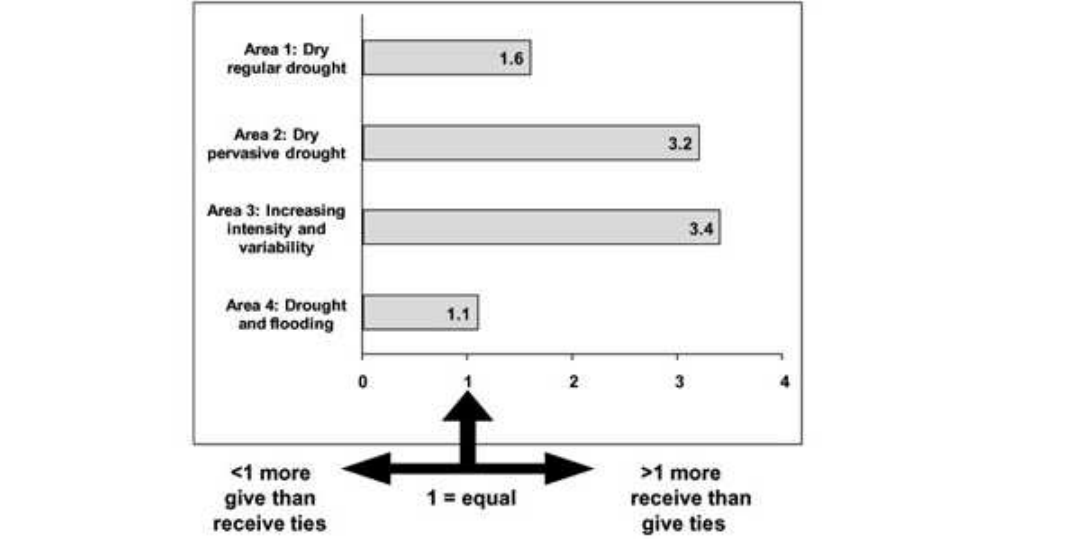
Fig. 3. Direction of reciprocity for each location. Note: Reciprocity results were generated from recorded data of all local and external exchanges for 121 households during 2003-4. These are total number of exchanges, including cash and noncash exchange, i.e.. labour, gifts and food, and represent investment in, and use of, social